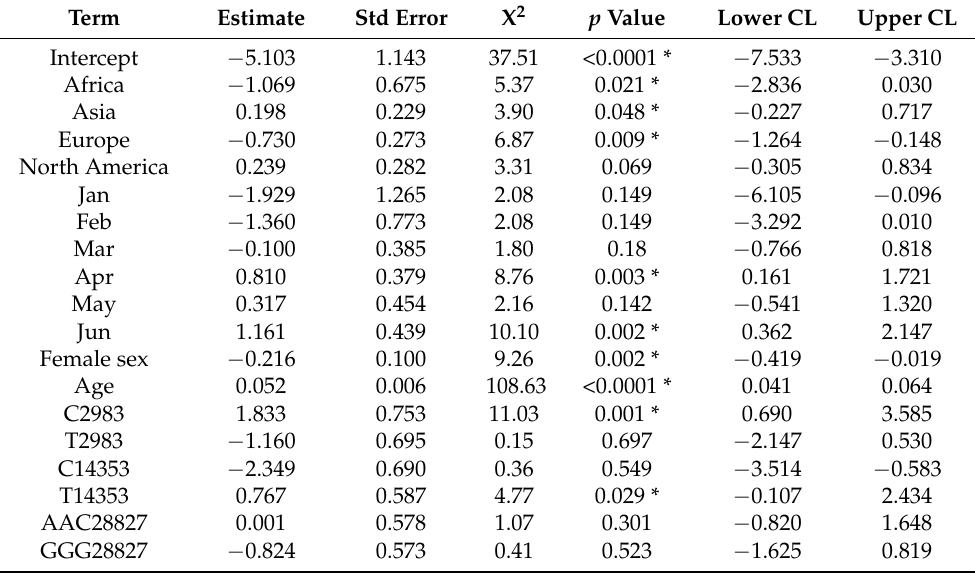
Table 2. Parameter estimates of the Generalized Linear Model (GLM) for patient mortality. Term Estimate Std Error